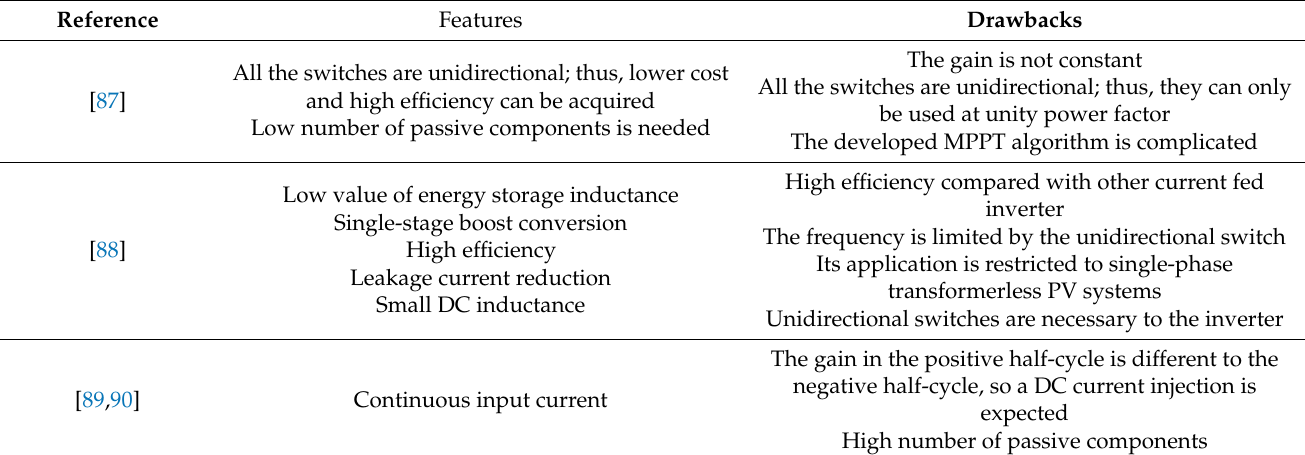
Table 6. Features and drawbacks of current-fed topologies